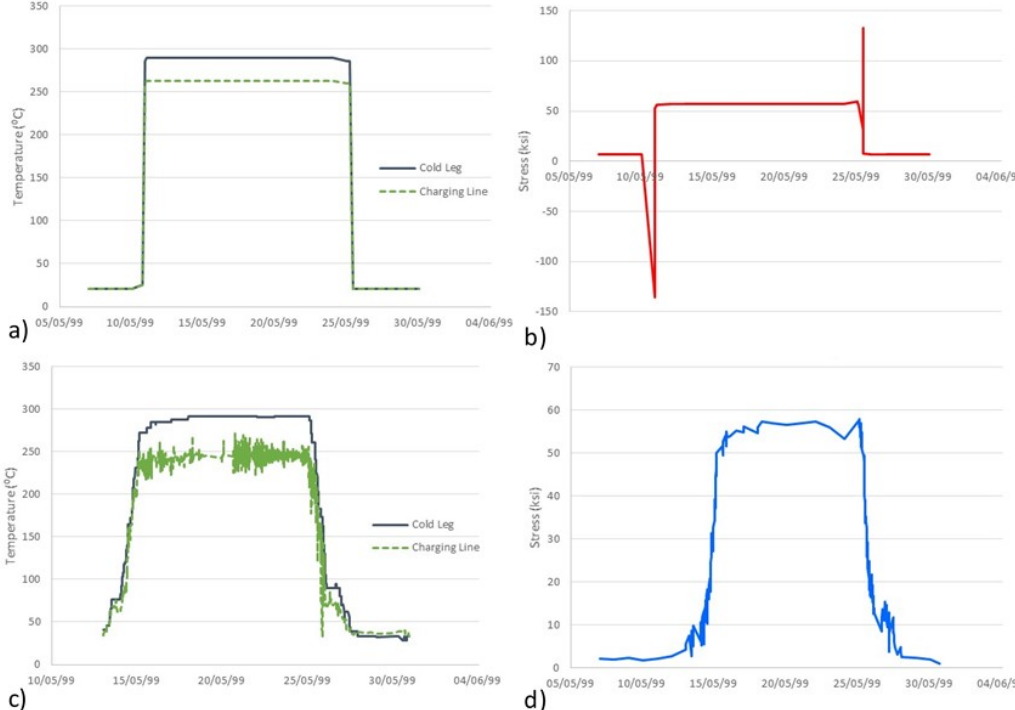
Figure 6. Temperature and stress evolution in both the cold leg and the charging line during the first sequence of transients. ( a ) Design temperature; ( b ) design stresses; ( c ) in-plant temperature; ( d ) in-plant stresses. Dates on the horizontal axes do not necessarily correspond to actual dates.